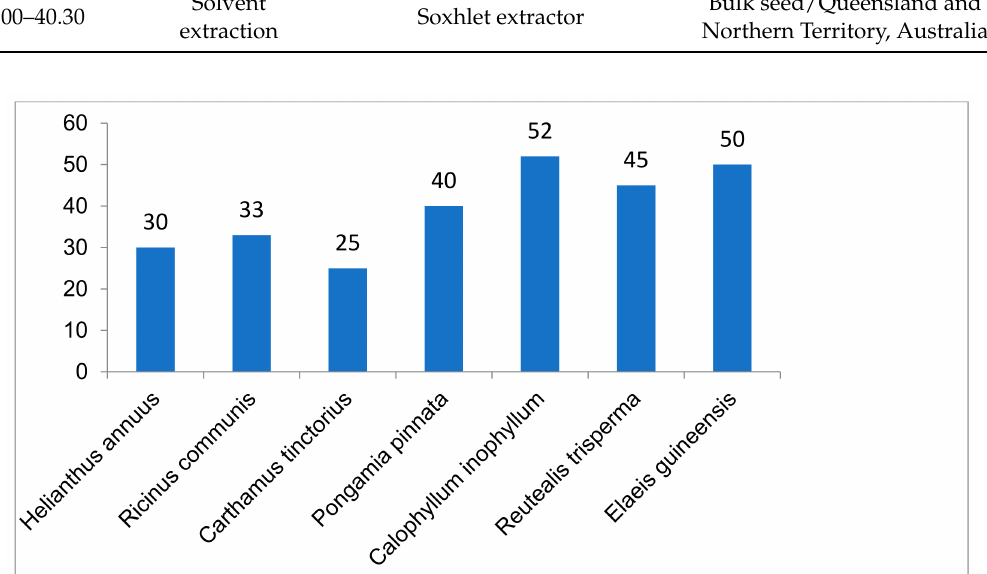
Figure 5. Average percentages of crude oil yielded by pongamia and other biofuel species, adapted from Ref.